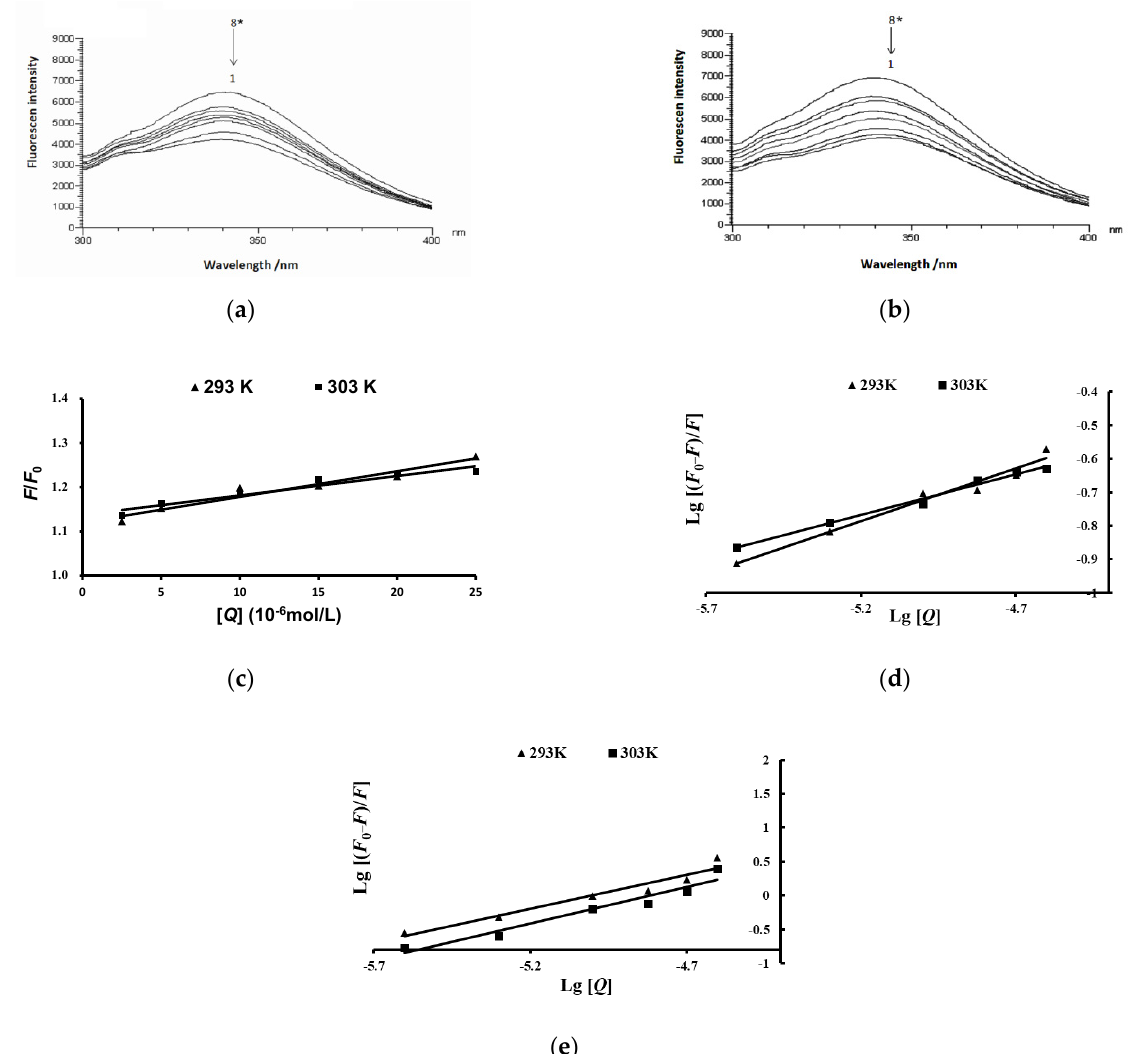
Figure 7. The fluorescence quenching effect of anthocyanins fromthe fruits of L . ruthenicum on pancreatic lipase. ( a , b ) The fluorescence quenching effects of the crude extract of anthocyanins and main compound anthocyanins on pancreatic lipase.*8 → 1 The final concentration rates of anthocyanins and pancreatic lipase were 0, 0.5:1, 1:1, 2:1, 4:1, 5:1, 10:1, and 20:1, respectively. ( c , d ) The Stern–Volmer curve of pancreatic lipase fluorescence quenching by anthocyanins. ( e ) Plot of Lg [( F 0 − F )/ F ] vs. Lg [ Q ].